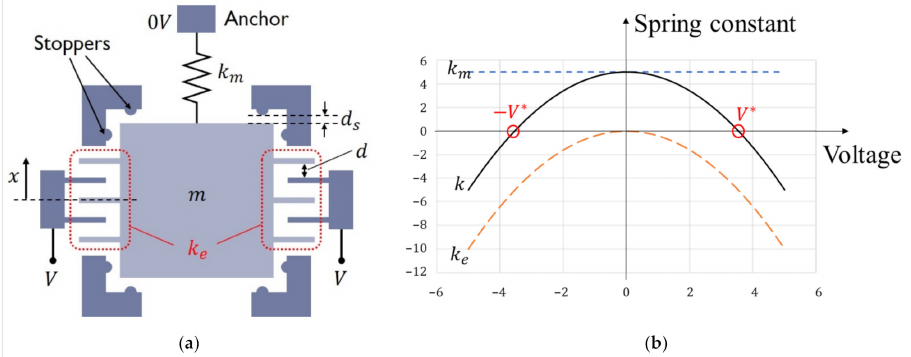
(cid:0) ∝ (cid:1) V 2 . Stoppers with gap